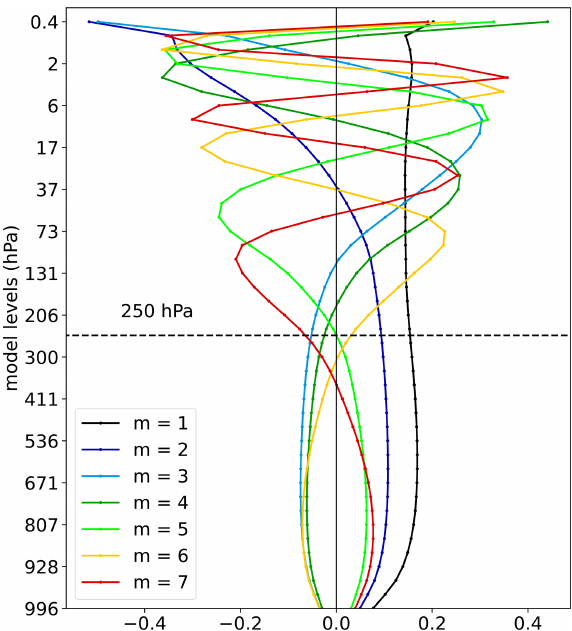
Figure 1. Vertical structure functions (VSFs) for the first seven vertical modes. VSFs are derived for 43 σ levels using the stabil- ity profile of ERA-Interim data. VSFs that do not change the sign below the tropopause (defined as 250hPa level) are troposphere– barotropic